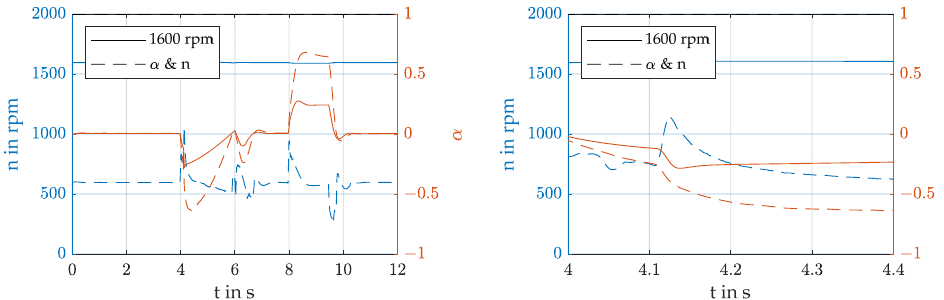
Figure 12. Motor speed and swash plate angle for a simulation with constant motor speed and the combination of motor speed and swash plate angle, cushion contact force 55 kN.